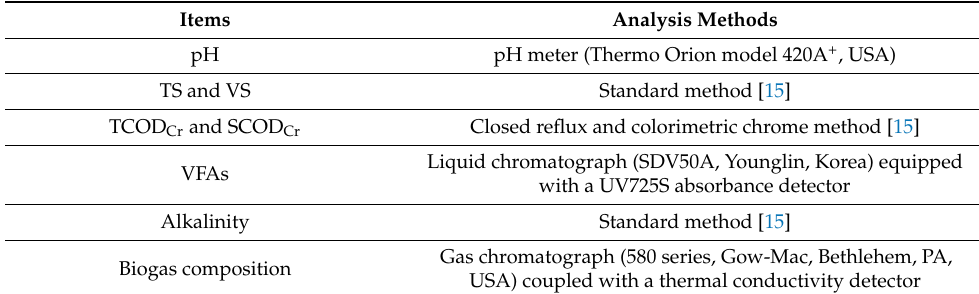
Table 1. Detailed measurement